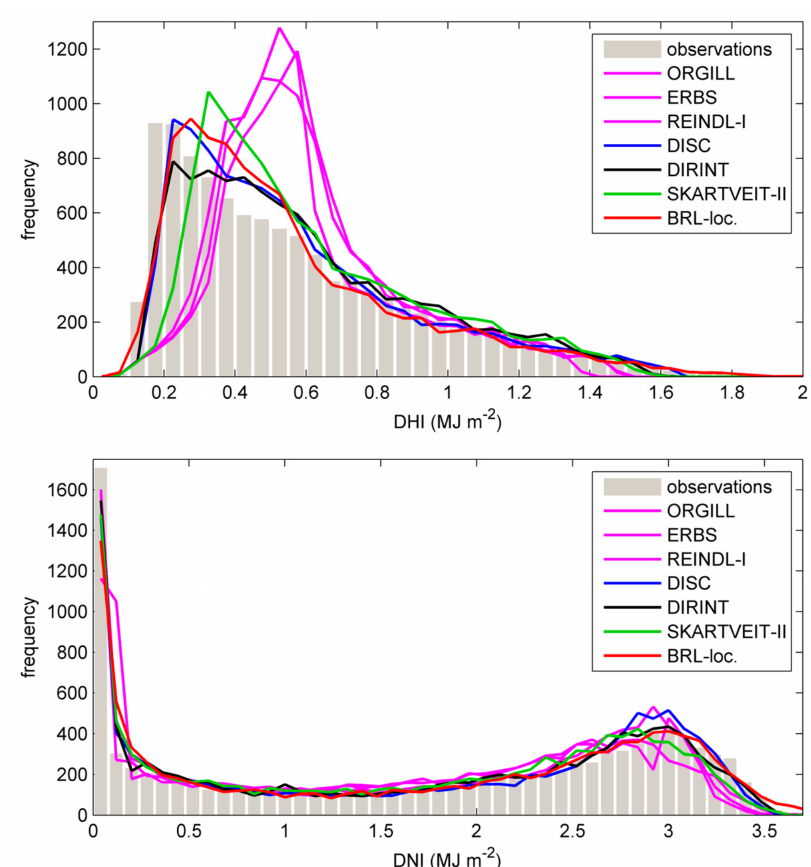
Figure 6. Empirical frequency distributions of DHI (upper panel) and DNI (lower panel) according to the best-performing decomposition models (bars show observations; lines show estimates). Three widely-used single-predictor models are also shown for comparison (magenta lines). See Table 1 for the model